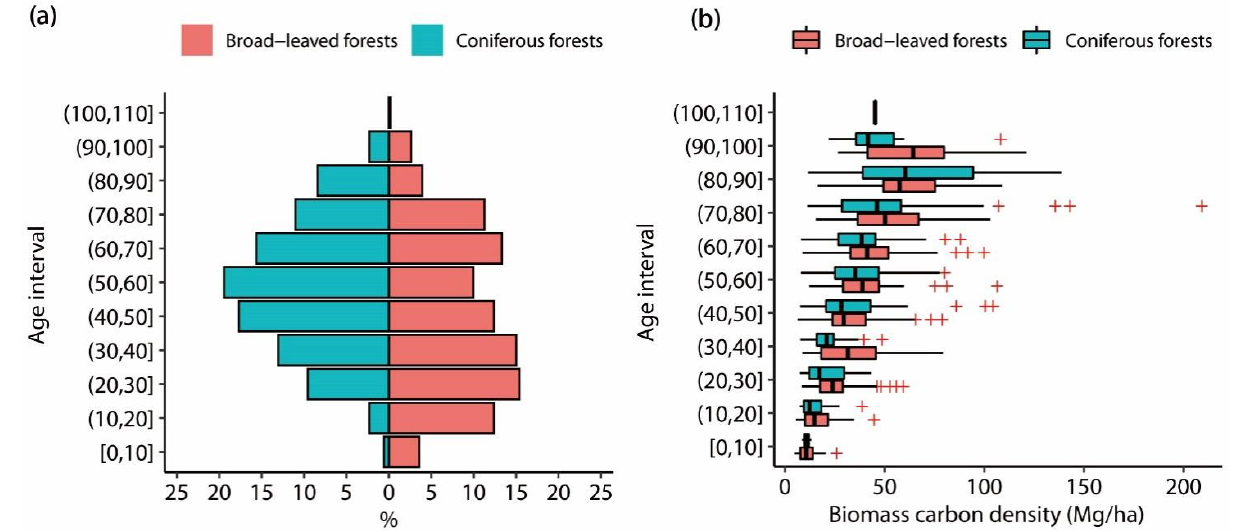
Figure 3. Forest age structure ( a ) and average biomass carbon density ( b ) of different age intervals of natural broad-leaved and coniferous forests in Shanxi, China.